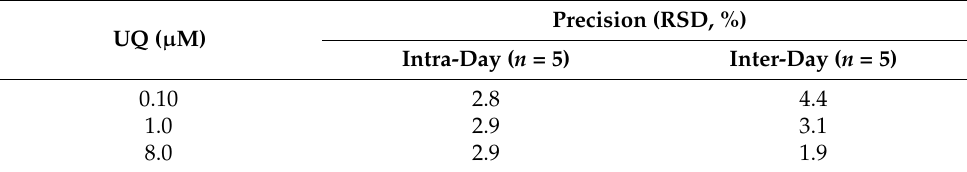
Table 2. The results of the reproducibility study of the HPLC-CL with reduction column.